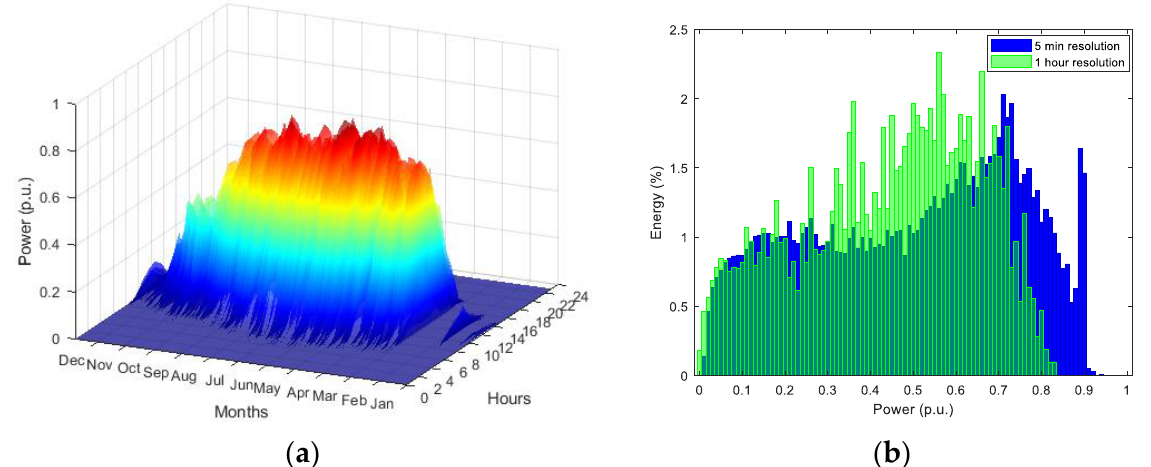
Figure 6. 3D power profile of the reference solar power plant ( a ) and distribution of annual energy versus AC output power ( b ).